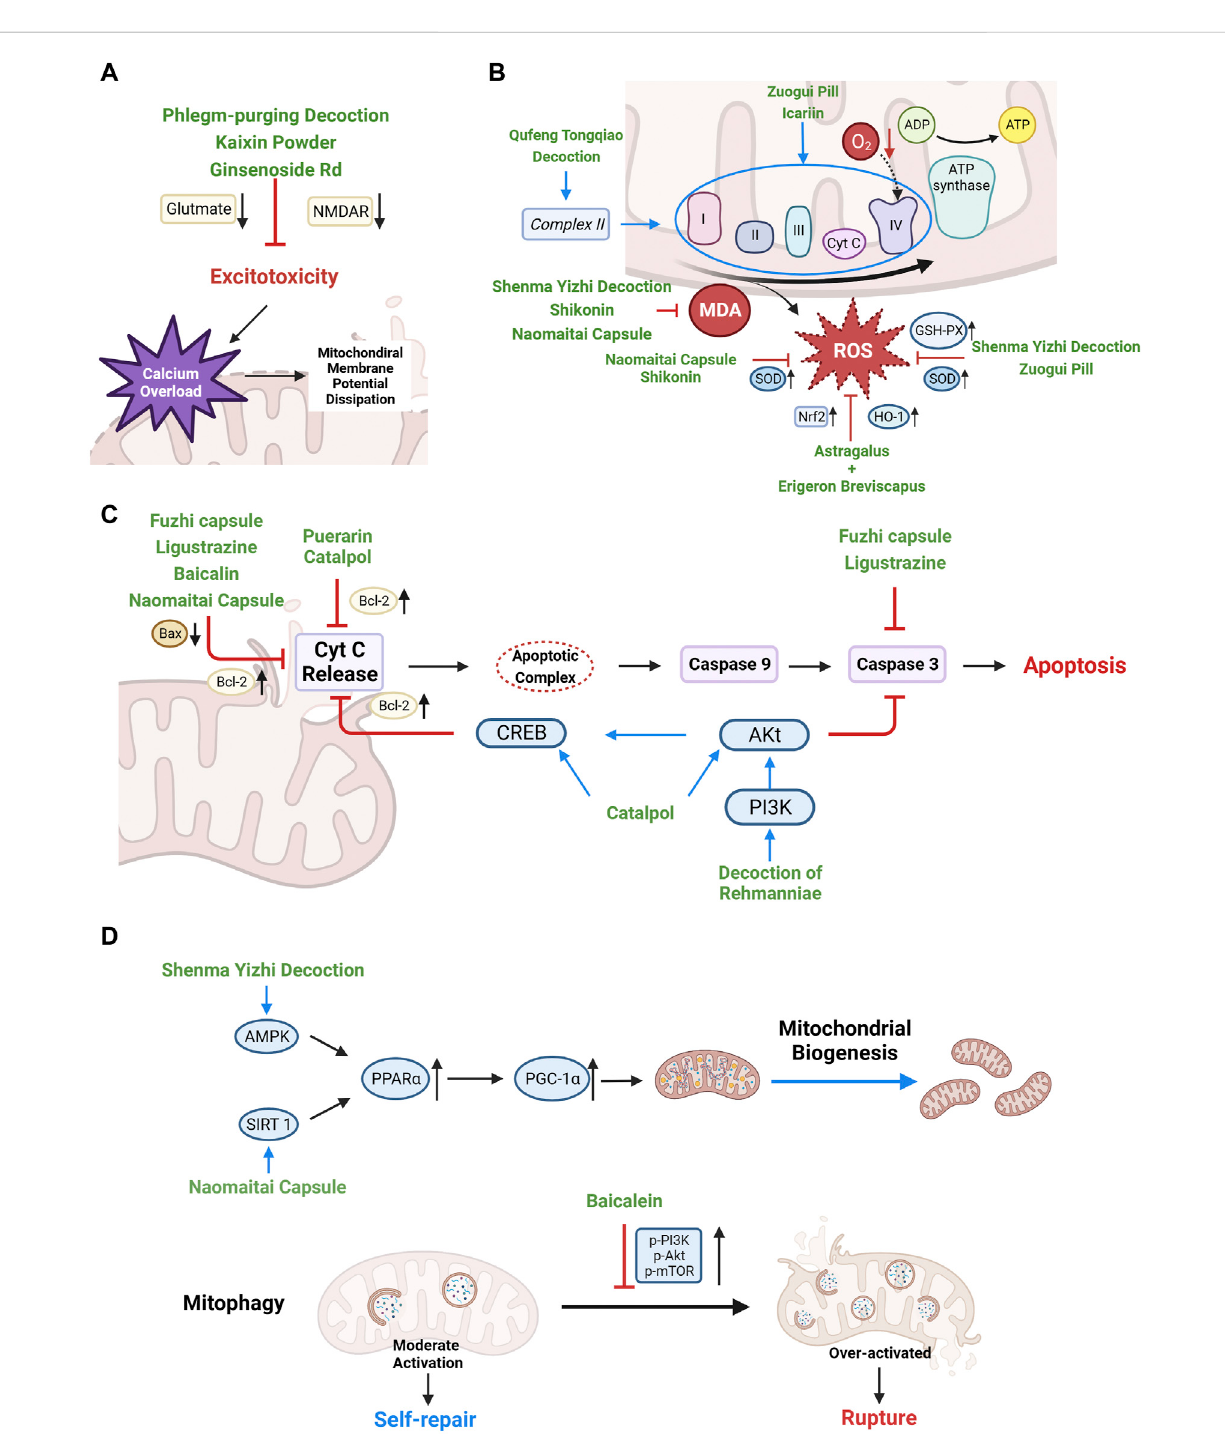
FIGURE 3 Therapeutic mechanisms of Chinese herbal medicine targeting mitochondrial dysfunction and self-regulation disorder after CCH. (A) Stabilizing mitochondrial membrane potential, reducing mitochondrial calcium overload, and preventing mitochondrial rupture by alleviating excitotoxicity. (B) Enhancingantioxidantenzymeactivity,protectingETCtoreducingROSproduction. (C) Regulating theexpressionofBcl-2andBaxtoreducetherelease of mitochondrial pro-apoptotic factors. (D) Upregulating PGC-1 α and inhibiting mitophagy overactivation to restore mitochondrial